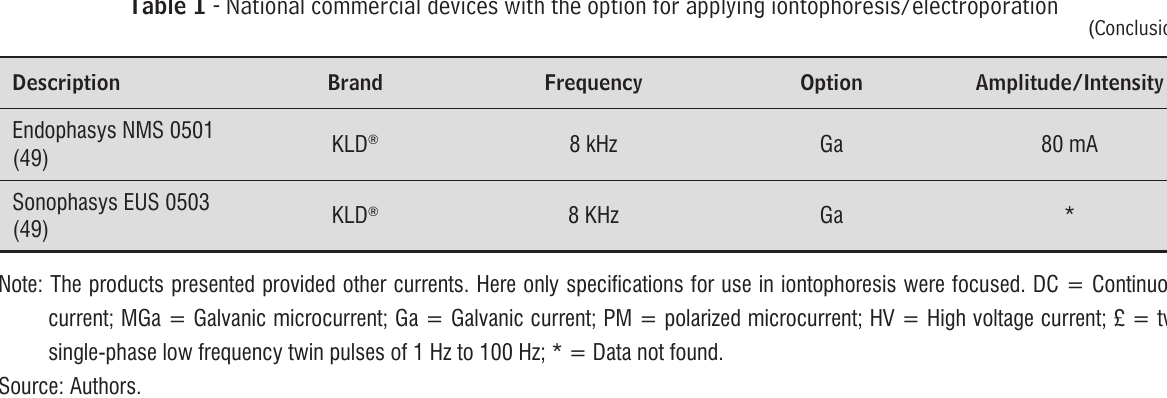
Table 1 - National commercial devices with the option for applying iontophoresis/electroporation